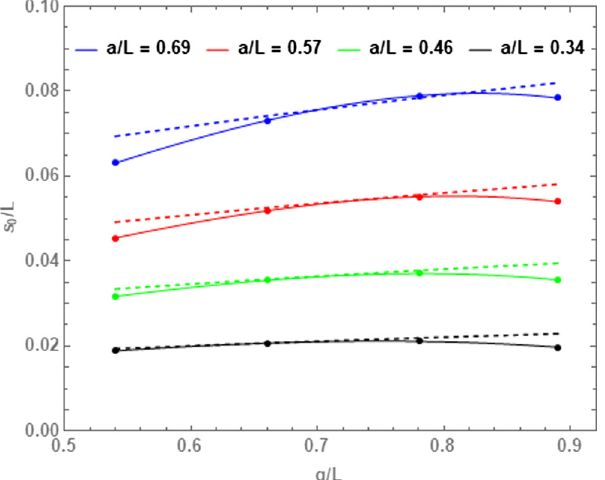
FIG. 34. The short-range wakes for representative cells 1, 15, 25, 30, 35, 45 and 60 of a Gaussian tapered structure with L ¼ 0 . 5 mm, σ ¼ 0 . 5 GHz and Δ ω = 2 π ¼ 1 . 5 GHz calculated via the CFD code (solid) and the fitted wakes (dashed) found by Eq. (45). The average wakes are also